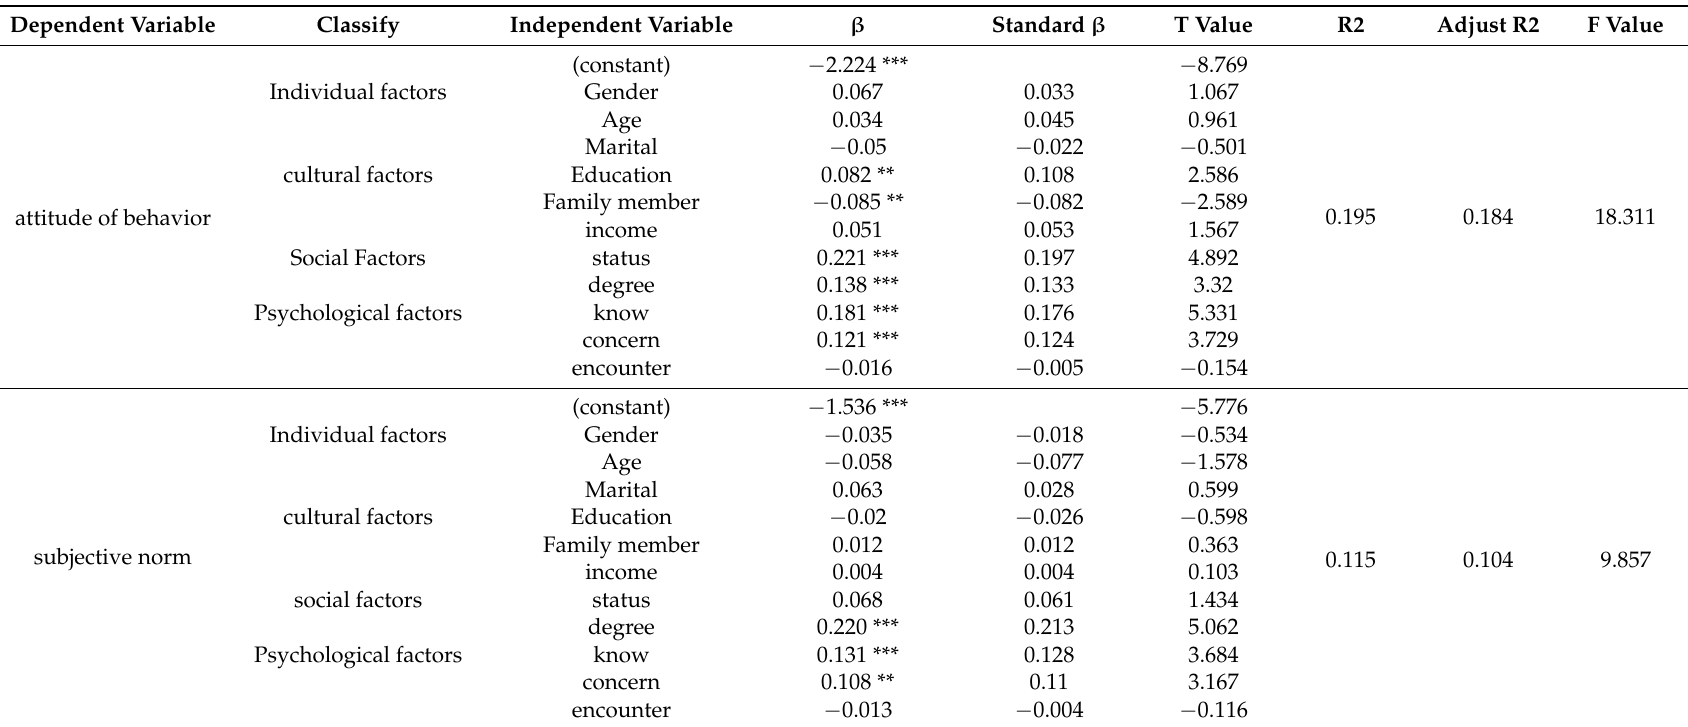
Table 6. Regression analysis of consumer characteristics on three dimensions of planned behavior theory and consumer